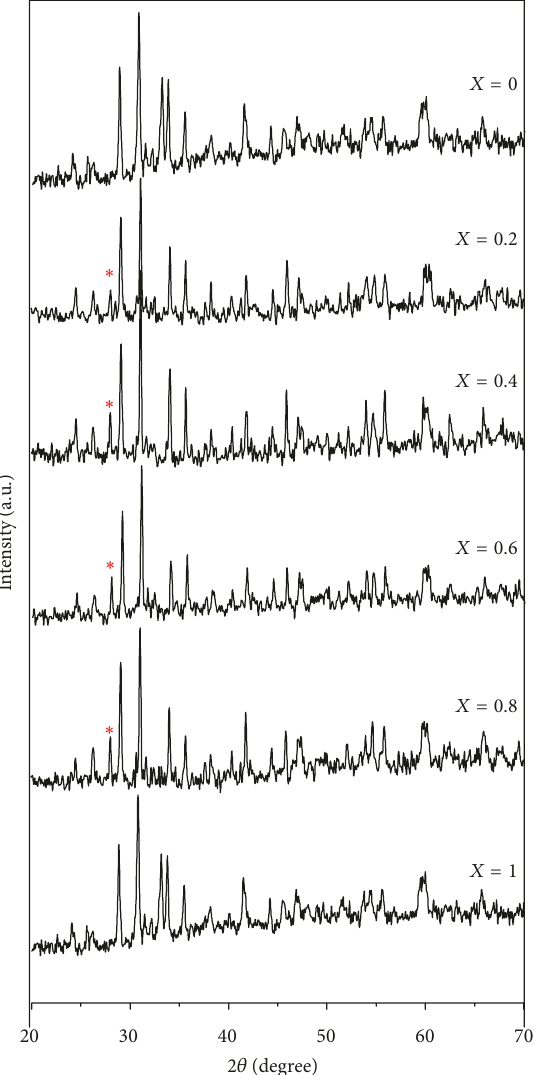
Figure 2: XRD pattern of Gd 1−𝑥 Y 𝑥 Mn 2 O 5 ( 𝑥 = 0 , 0.2, 0.4, 0.6, 0.8, and 1) at room temperature. ∗ shows the additional peaks not fitted with Rietveld